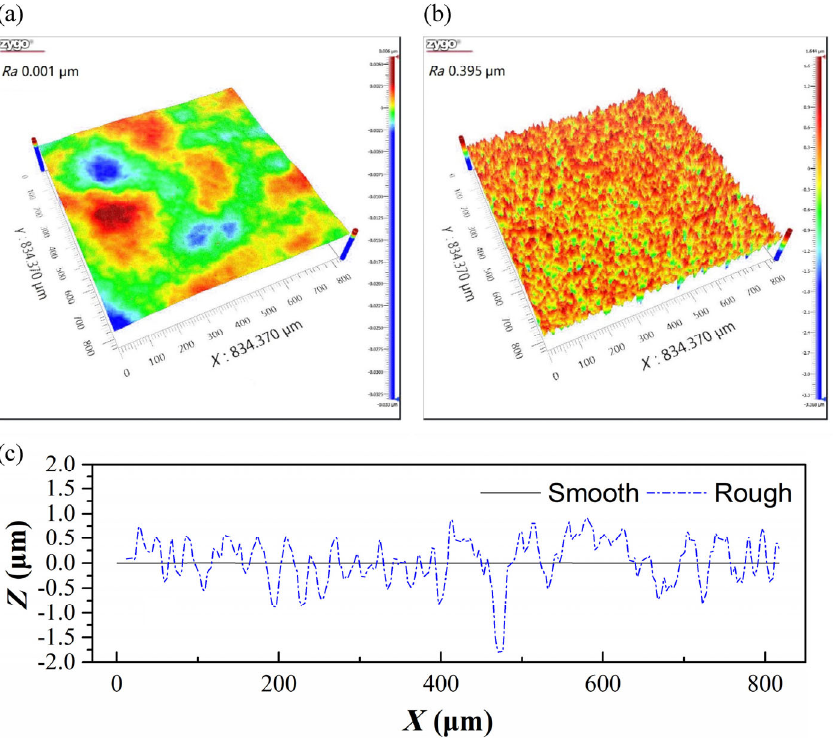
Fig. 4 Three-dimensional morphology of (a) smooth silicon surface and (b) rough silicon surface; (c) surface profile of two silicon